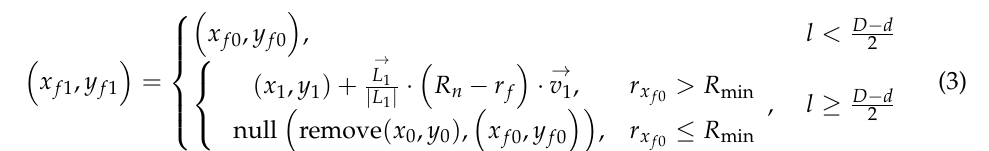
shown in Figure 17. The continuous points (𝑥 𝑓−𝑛 , 𝑦 𝑓−𝑛 ) → (𝑥 𝑓𝑛 , 𝑦 𝑓𝑛 ) around the current